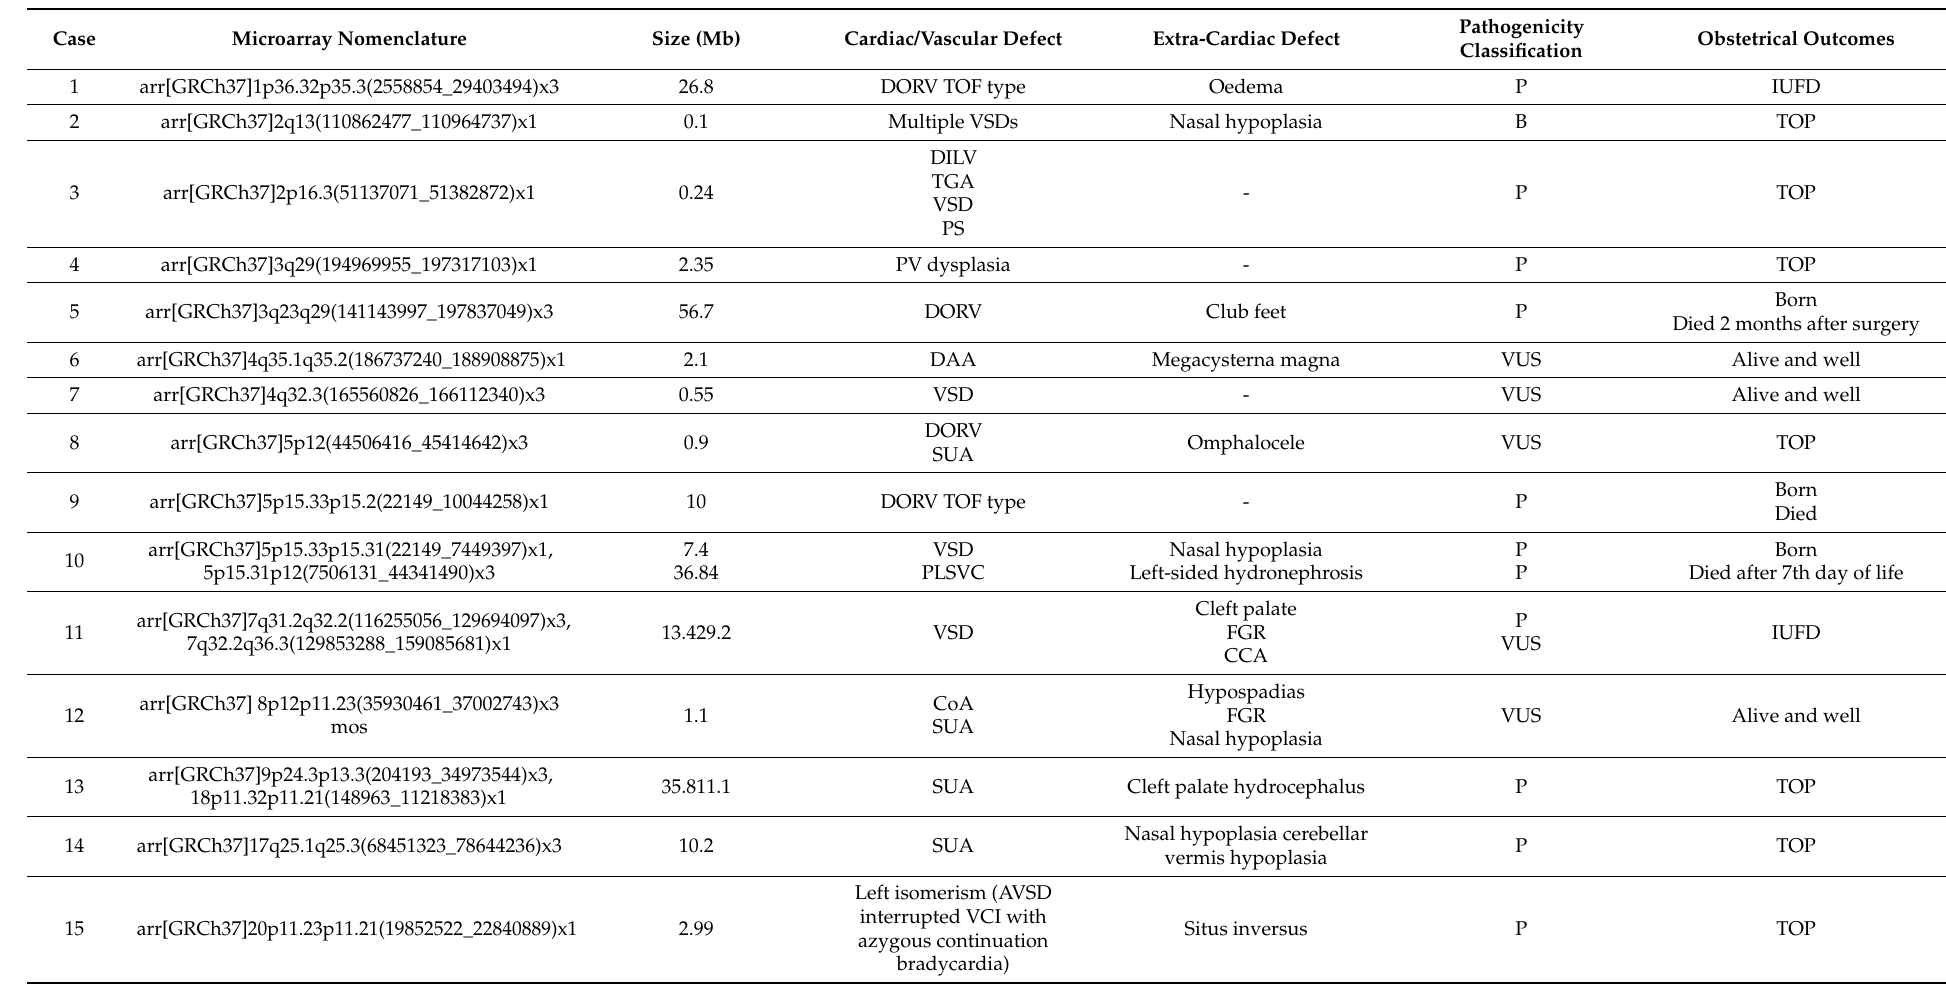
Table 3. Copy number variants found by aCGH in fetuses with cardiovascular anomalies among 1005 pregnant women undergoing invasive prenatal